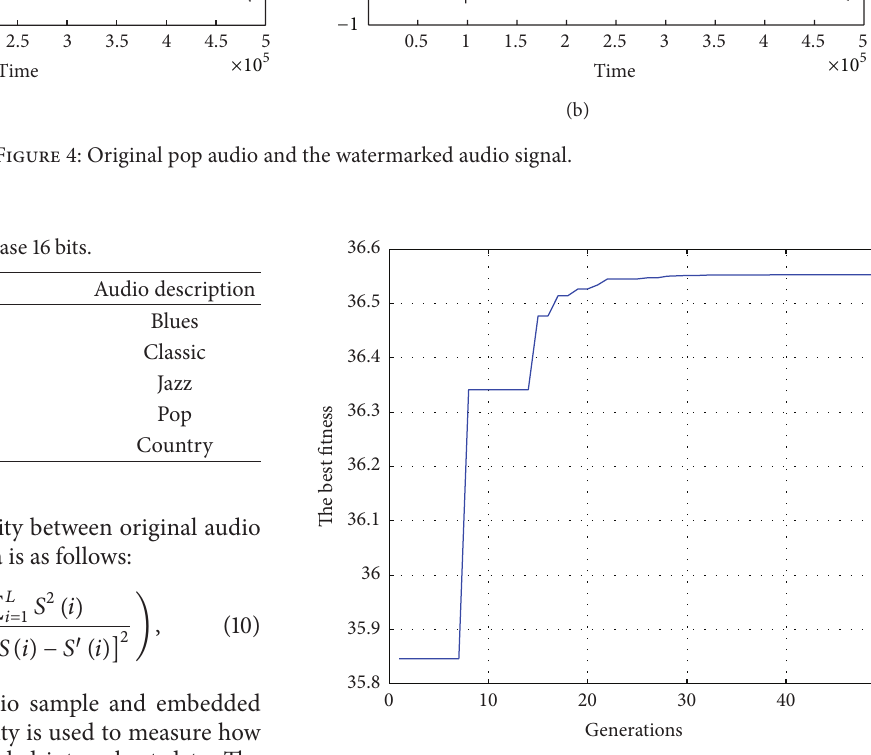
Figure5:ConvergencecurvesofobjectfunctionwithDEalgorithm.